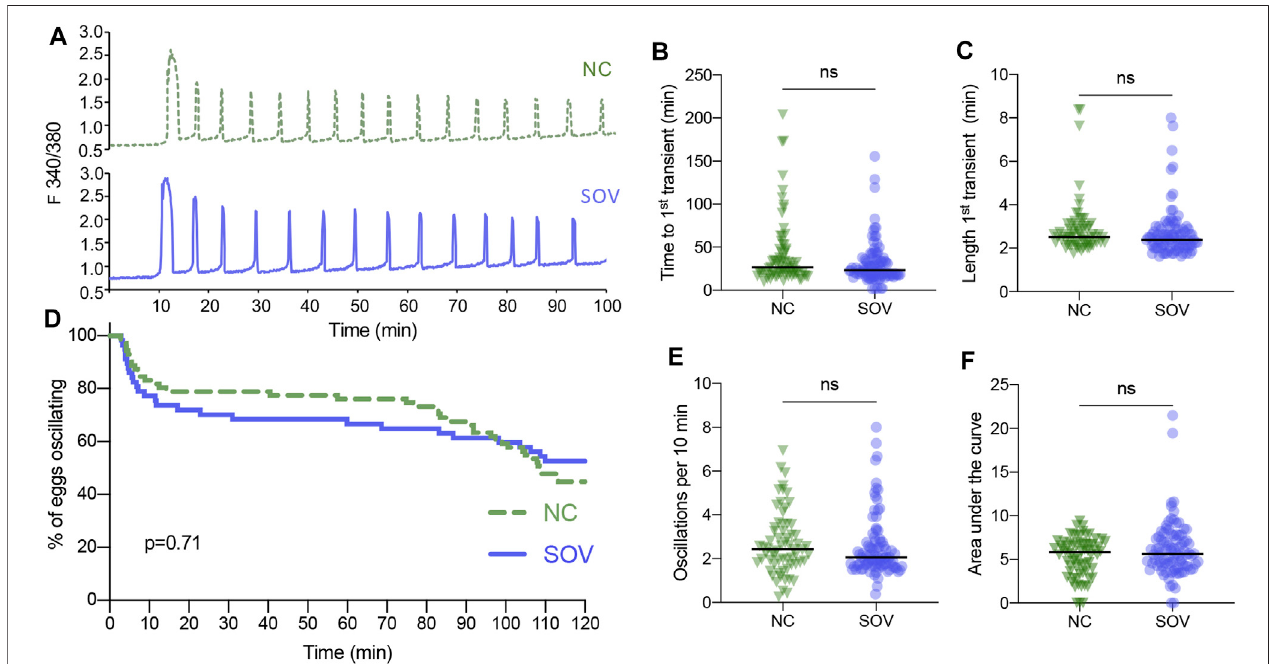
FIGURE 2 | Calcium oscillatory patterns following fertilization of MII eggs from naturally cycling (NC) and superovulated (SOV) mice. (A) Representative calcium traces. (B) Time to the fi rst transient. (C) Length of the fi rst calcium transient. (D) Percentage of eggs that continued to display calcium oscillations during 120 min. p -value indicated on graph. (E) Oscillation frequency averaged over the fi rst 60 min of oscillations. (F) Area under the curve of calcium signal during the fi rst 60 min following fertilization. Graphs in (B,C,E,F) show median and all individual data points. ns, no signi fi cant difference.